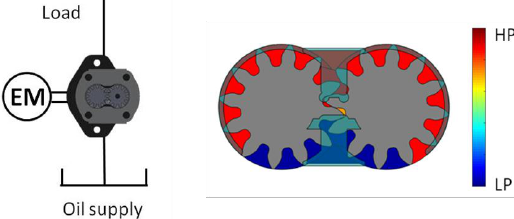
Figure 1. External gear pumps (EGP), and typical TSV pressure distribution for an EGP for high pressure applications.